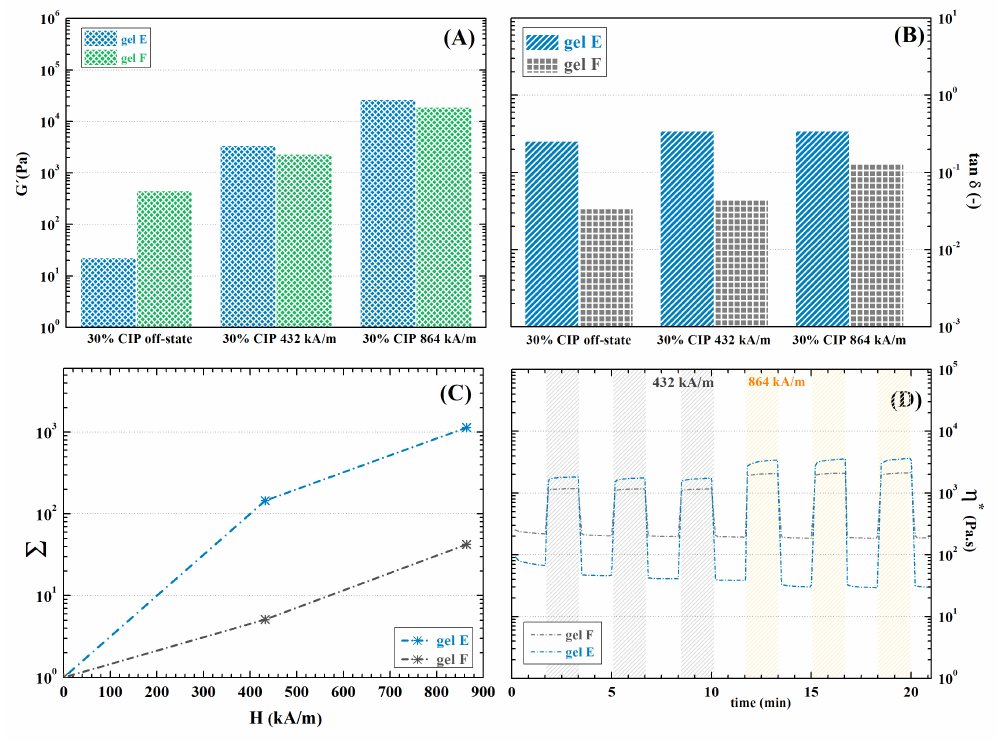
Figure 13. Mechanical characteristics obtained from rheological measurements of CIP-filled Schiff- base cross-linked hydrogels in an external magnetic field: ( A ) storage modulus; ( B ) damping factor; ( C ) intensity of MRE expressed as increase in storage modulus related to magnetic field intensity; ( D ) cyclic magnetic field